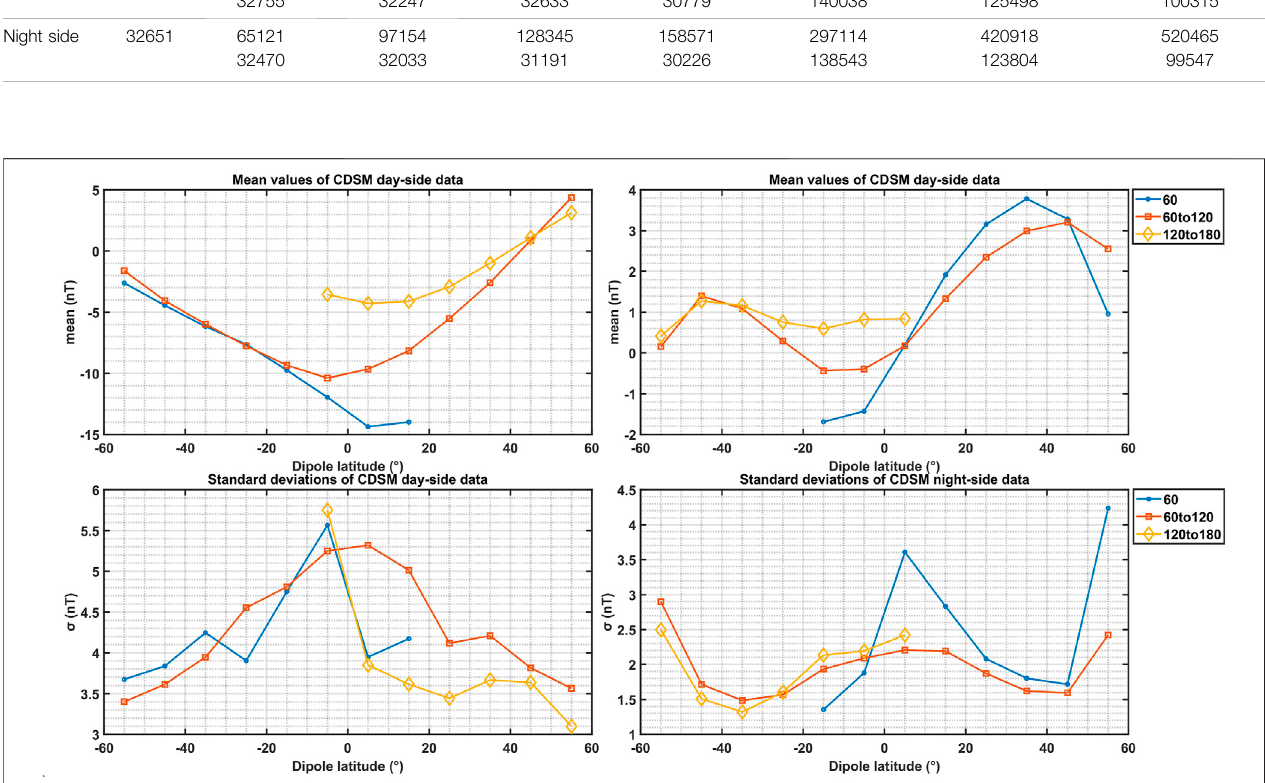
Frontiers in Earth Science |